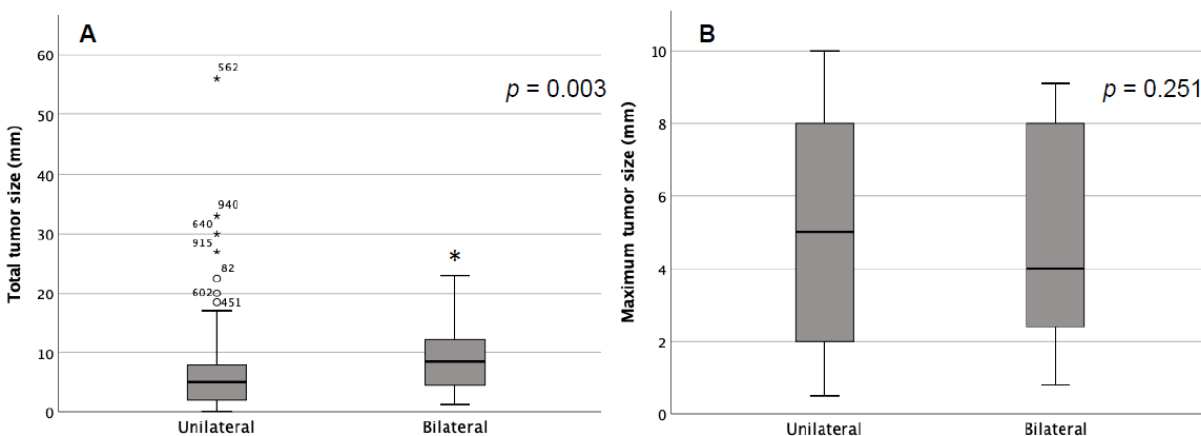
Figure 1. Total tumor size ( A ) and maximum tumor size ( B ) in unilateral and bilateral tumor manifestation. * statistically significant. Table 2. Logistic regression analysis for potential risk factors of bilateral tumor spread in papillary microcarcinoma. Parameter